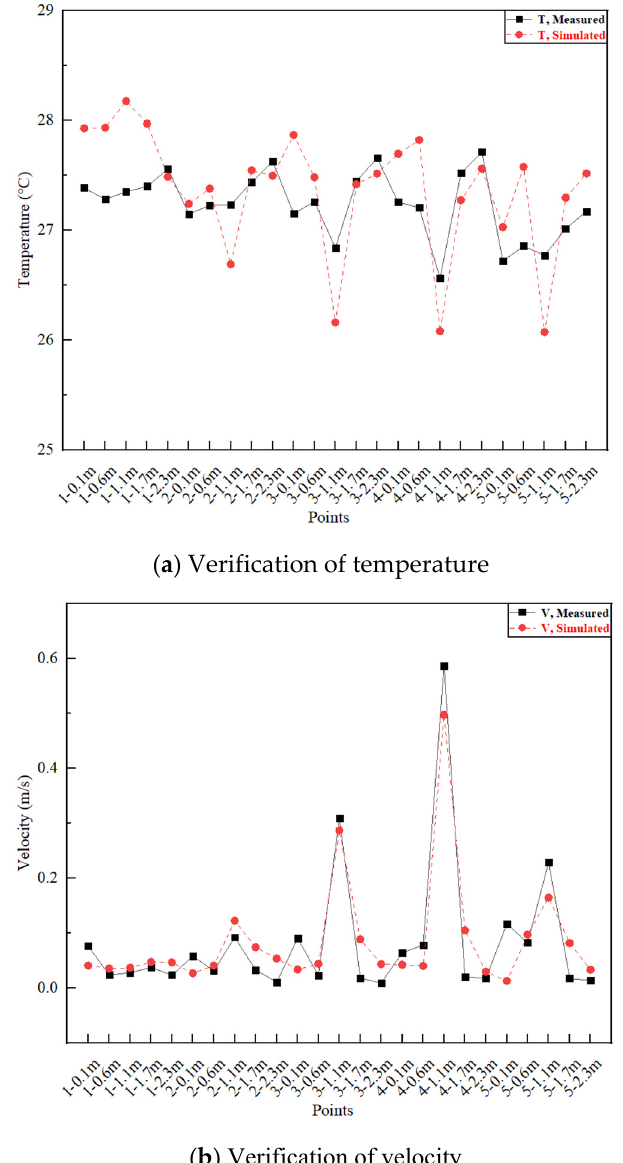
Figure 3. Comparison between simulated and measured data at 5 heights at sampling lines 1–5 (re-